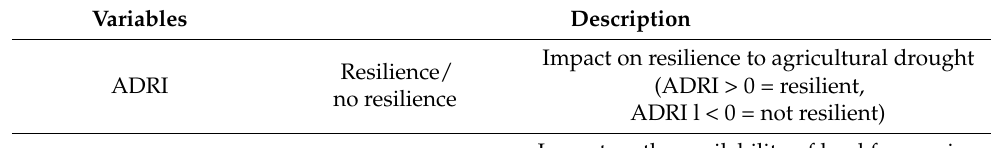
Table 1. Description of